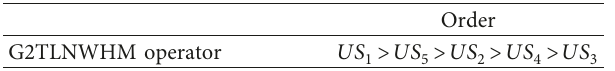
Table 4: Order of the university